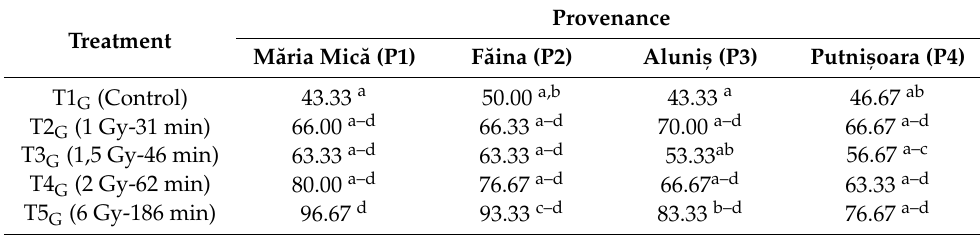
Table 3. Seeds’ germination (%) depending on the interaction between G treatments and provenance. Treatment